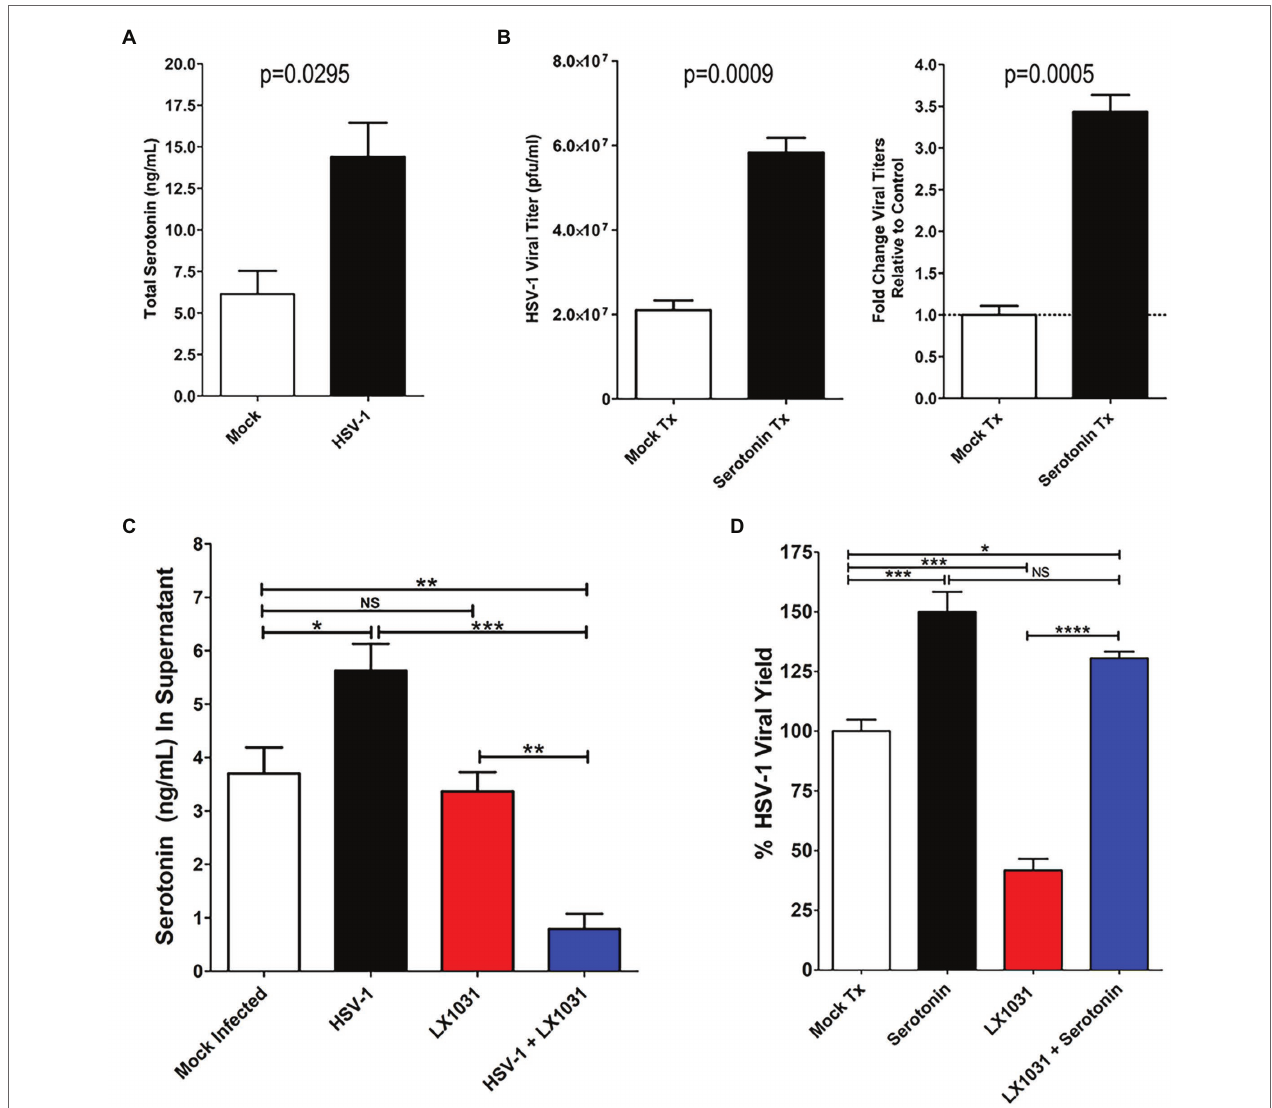
FIGURE 5 | Serotonin enhanced HSV replication is suppressed by pharmacological inhibition of TPH-1/2. (A) ELISA determination of total intra- and extra-cellular serotonin concentrations from mock- or HSV-infected cells. (B) HSV-1 viral yield (left panel) and fold increase in viral yield (right panel) were determined for infected cells either mock treated or treated with 50 μ M serotonin. (C) ELISA determination of extracellular serotonin concentration from supernatants of HSV-1 infected or mock-infected cells that had been mock treated or treated with 500 nM of the TPH inhibitor LX1031. (D) HSV-1 infected A549 cells were mock treated (Mock Tx), treated with 50 μ M serotonin (Serotonin) and 500 nM LX1031 (LX1031), or cotreated with 500 nM LX1031 and 50 μ M serotonin (LX1031 + Serotonin). Viral titers were determined using a limiting dilution plaque formation assay and were expressed as a percentage of Viral Yield Relative to Mock Treatment. Data are graphed as mean ± SEM. (* p < 0.05, ** p < 0.01, *** p < 0.001, **** p < 0.0001, and NS: not